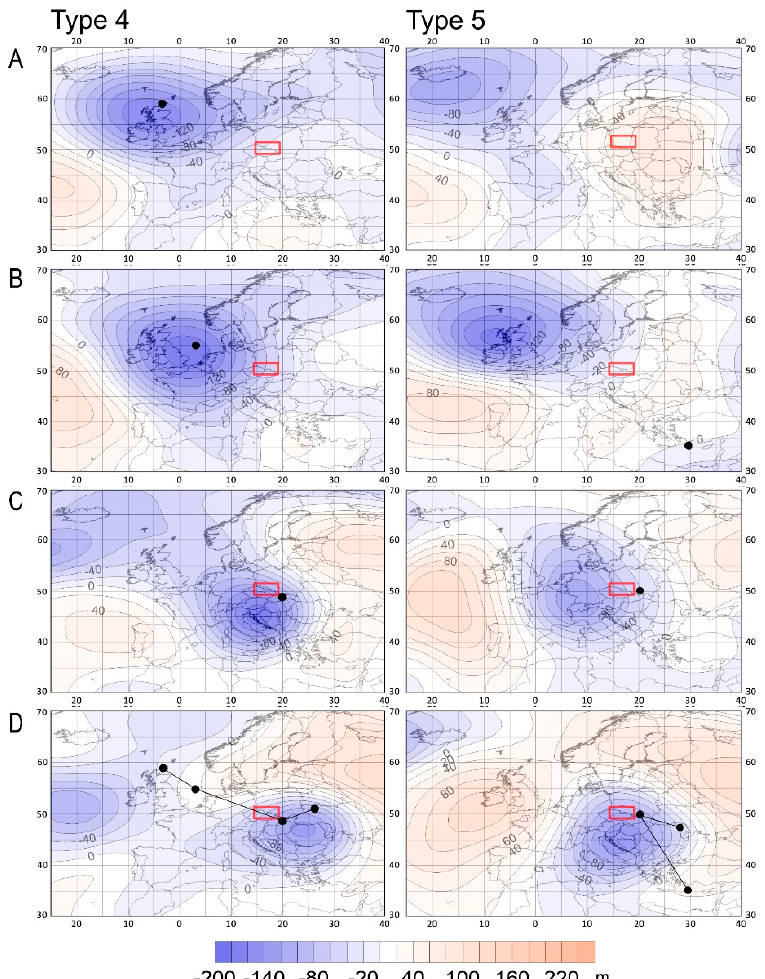
Figure 8. Circulation types 4 and 5 mean Z500 anomalies (m) 6 days ( A ), 4 days ( B ), and 2 days ( C ) before the flood culmination and on the flood culmination day ( D ); black dots indicate centers of negative SLP anomalies (repeated from Figure 6) and in column D cyclone tracks are marked; region of Polish Sudeten Mountains marked as red rectangle.